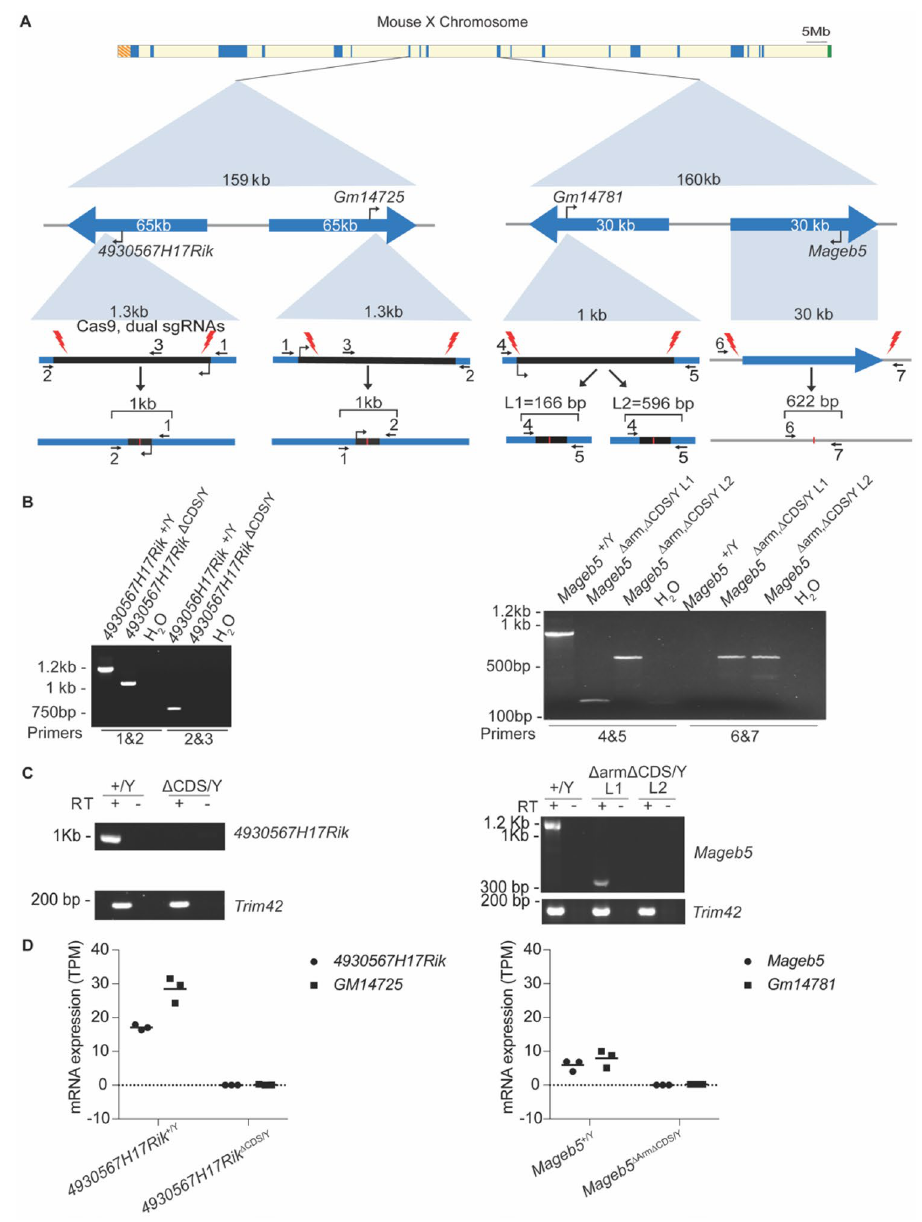
Figure 2. Creation of 4930567H17Rik ∆CDS/Y , and Mageb5 ∆Arm∆CDS/Y mice. ( A ) Top: Schematic of the mouse X chromosome showing singleton palindromes (blue) the pseudoautosomal region (green, right end), and centromere (orange, left end). Middle: Diagrams of the 4930567H17Rik and Mageb5 palindromes showing palindrome arms as blue arrows. Bottom: Coding sequence of 4930567H17Rik and one copy of Mageb5 with CRISPR cut sites (red lightning bolts) and genotyping primers (black arrows with numbers). ( B ) PCR genotyping of DNA from mutant and wild type 4930567H17Rik and Mageb5 mice. Numbered primers correspond to panel A. ( C ) RT-PCR of 4930567H17Rik and Mageb5 cDNA from one 4930567H17Rik line and Mageb5 L1 and L2. L1 shows a product due to a small portion of the transcript still being produced. ( D ) RNA- seq data for 4930567H17Rik ∆CDS/Y , and Mageb5 ∆Arm∆CDS/Y L1 mice. GM14725 and Gm14781 are the palindrome arm gene copies of 4930567H17Rik and Mageb5, respectively. See Fig S2 for full-size images of ( B , C